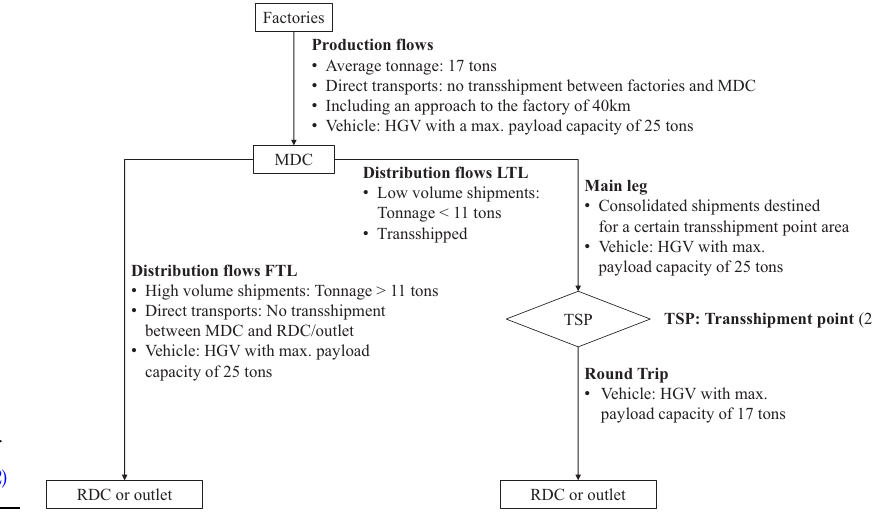
Figure 3. GHG analysis: transportation flows. Model adopted from Kellner and Igl